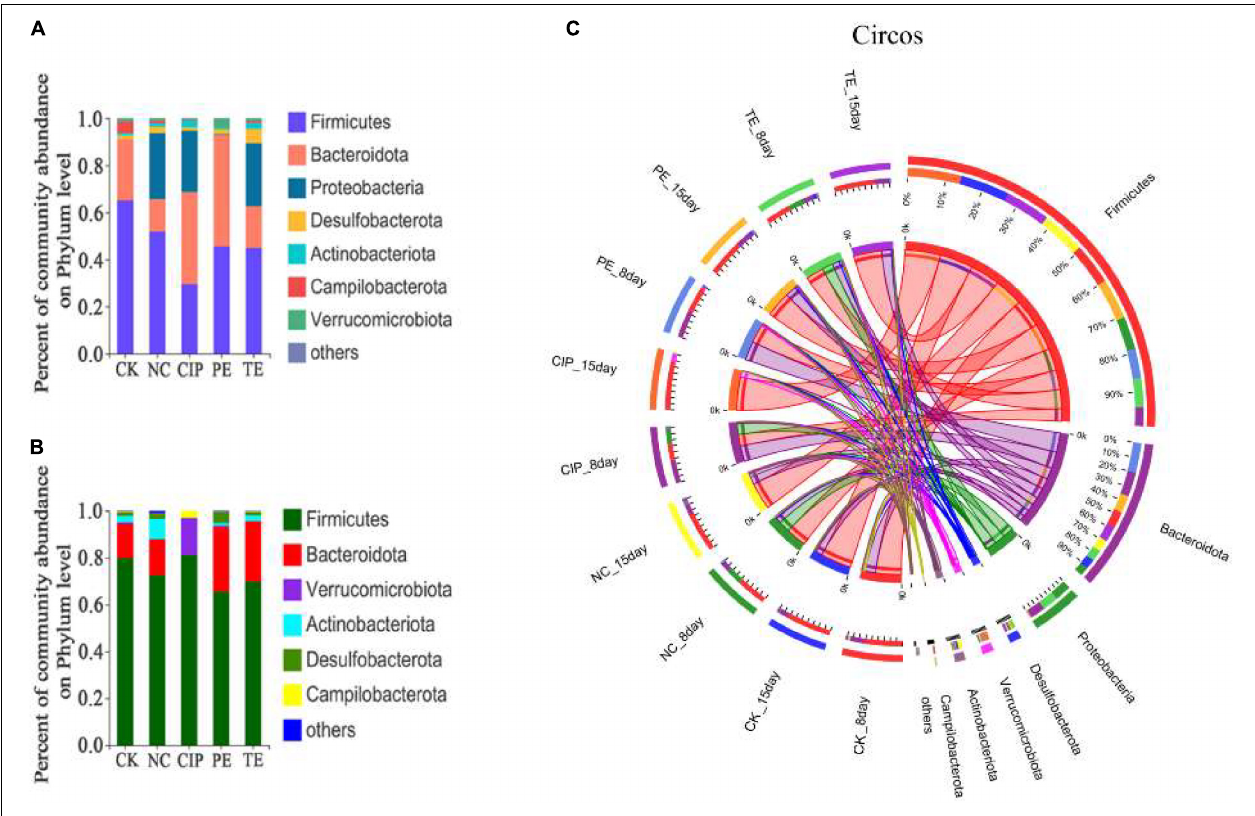
FIGURE 10 | Percent of community abundance on phylum level. (A,B) Bar plots of the taxonomic composition at the phylum on day 8 and 15. (C) Circus